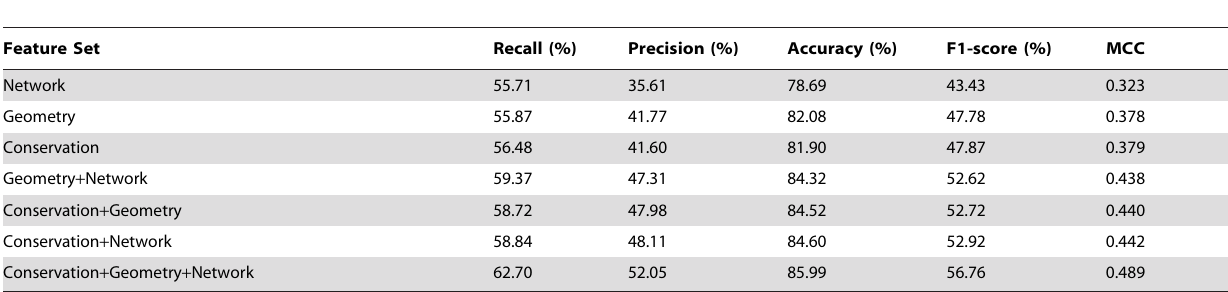
Table 3. Performance of different predictors tested on Dataset